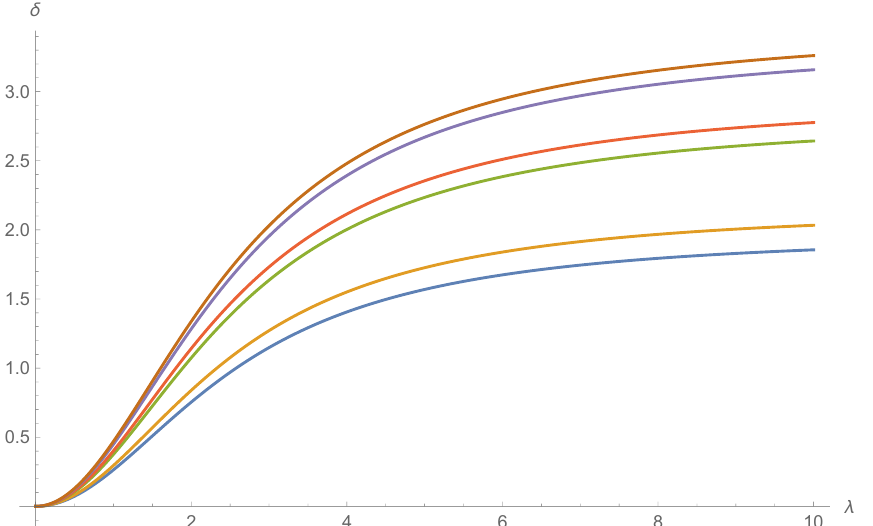
Figure 7 . Anomalous dimension of the spin s current, for s = 3 ; 4 ; 5 ; 6 ; 7 ; 8 as a function of (cid:21) M (to be multiplied by M=N ).